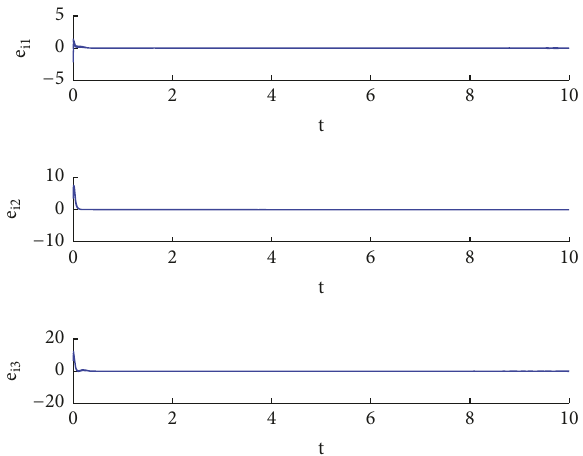
Figure 8: Evolution of adaptive parameters 𝑚 𝑖𝑗 (𝑡), 𝑖,𝑗 = 1, 2, .. ., 10